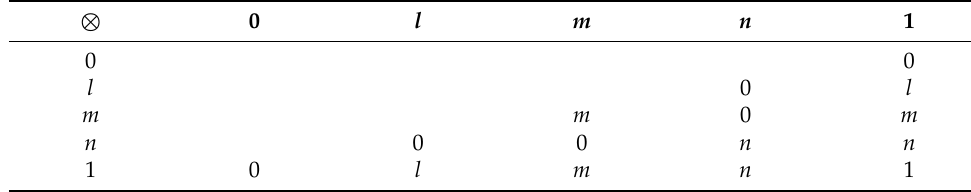
Table 13. The partial operation ⊗ .